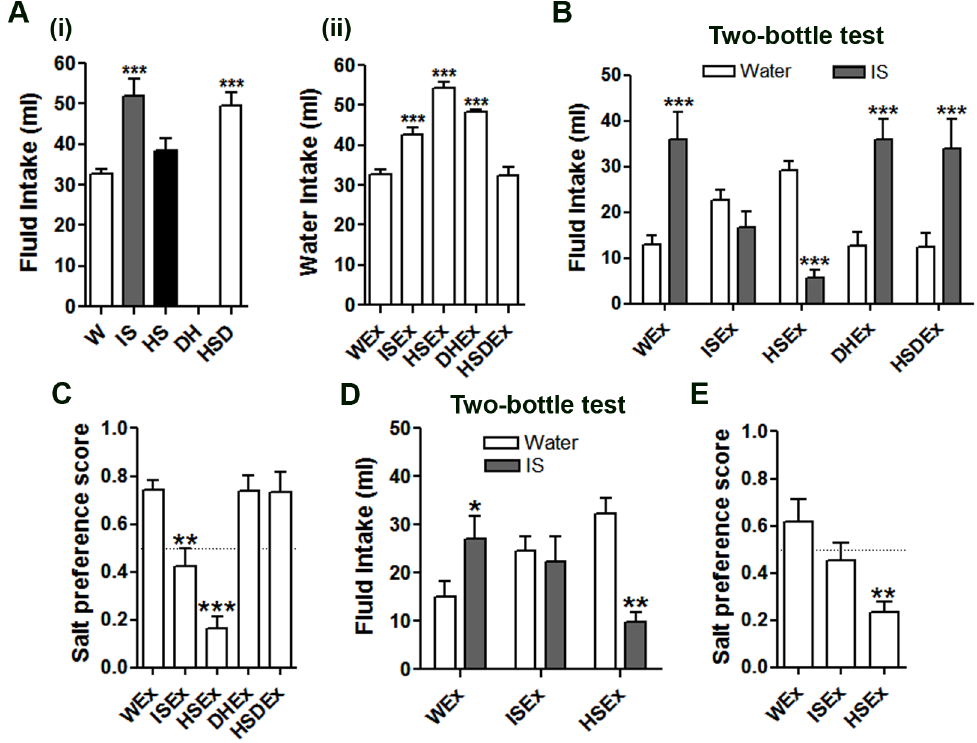
Figure 2. A dramatic and lasting switch in salt preference after 24 h one-bottle tests with IS and HS solutions. Ai, Mean fluid intake following 5 different 24 h one-bottle treatments, control, IS, HS, DH and 4% HSD. Aii, water intake measures for the proceeding 24 h after treatment. B, mean intakes of water and IS solution in two-bottle choice tests performed 7 d after one-bottle tests. C, mean salt preference scores for all groups calculated from the total fluid intake data in B. D, the two-bottle choice tests were repeated 35 d after one-bottle tests for control WEx, ISEx and HSEx groups. Values are means + SEM of n=6–10 animals per group. E, mean salt preference scores for all groups calculated from the total fluid intake data in D. *p , 0.05, **p , 0.01, ***p , 0.001. DH, dehydrated; HS, hypertonic saline; HSD, high salt diet; HSEx, hypertonic saline exposed; IS, isotonic saline ISEx isotonic saline exposed; W, water; WEx, water exposed.